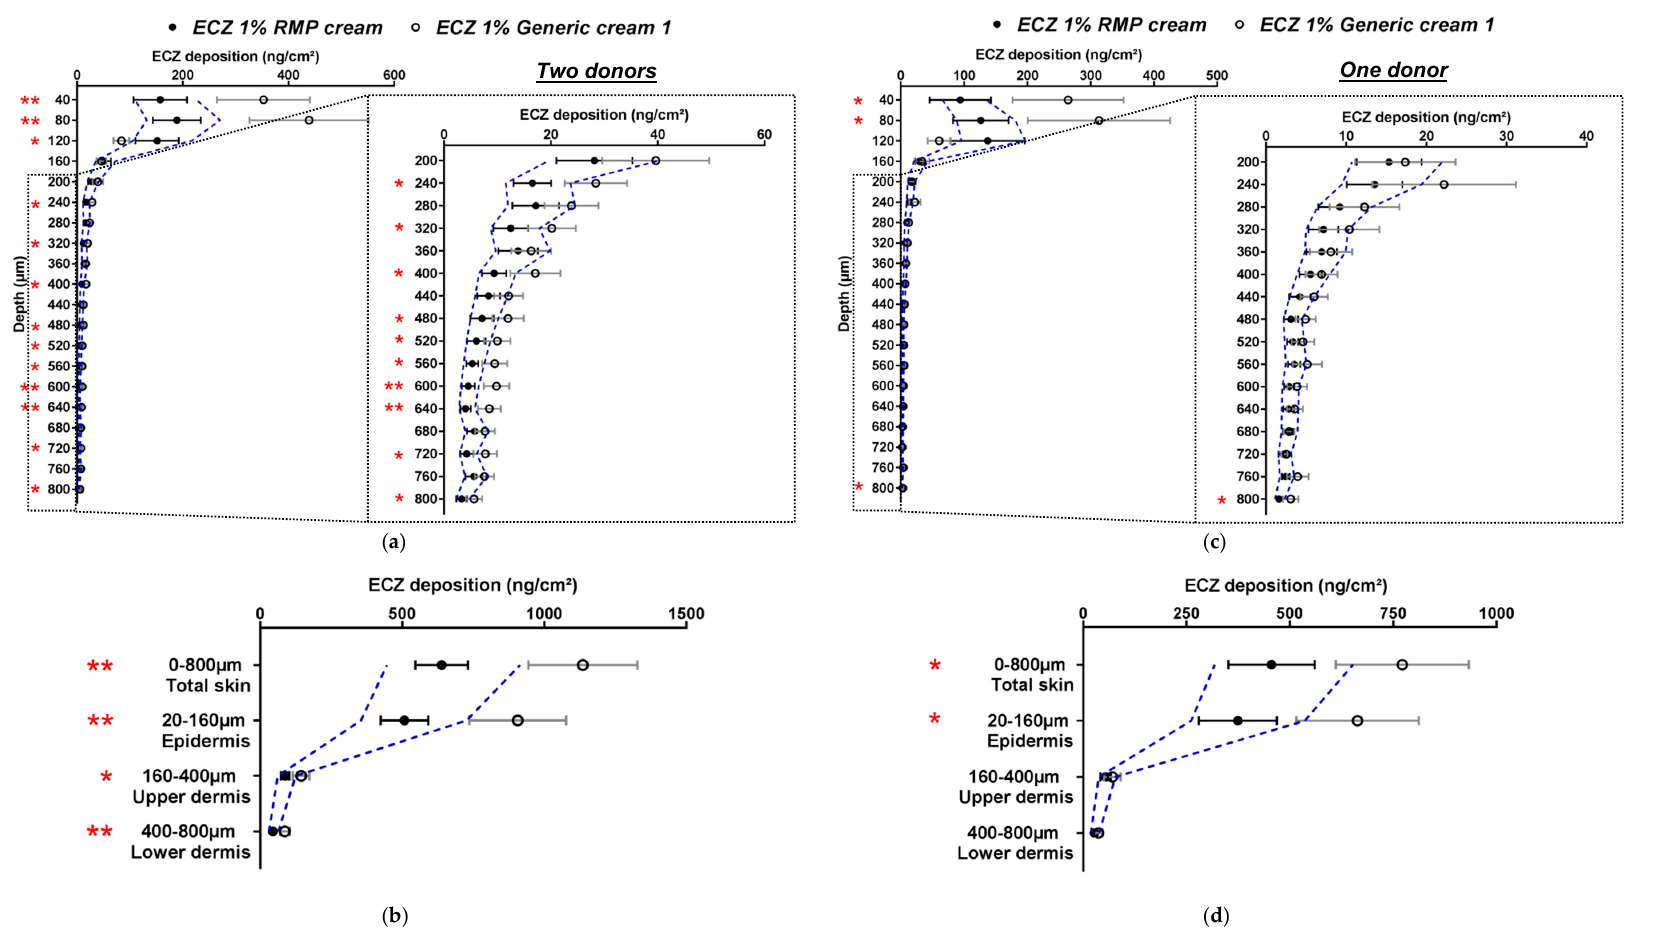
Figure 2. Cutaneous biodistribution profile of ECZ: ( a ) in porcine skin lamellae (2 × 20 µm + 19 × 40 µm) to 800 µm (full depth) and ( b ) as a function of position in the anatomical regions of the skin (epidermis, upper and lower dermis) and in total skin. Tested groups: reference medical product (ECZ 1% RMP cream) ( ) and non-bioequivalent “negative control” (ECZ 1% ethanolic solution) ( ). (Mean ± CI 90% ; n = 12 and n = 6, respectively). Intervals of acceptance criteria were calculated based on the mean ECZ deposition from the RMP; ( ) interval of 80.00–125.00% and ( ) interval of 69.84–143.19%. P -values were calculated using a Student’s t test; statistically significant differences are denoted by asterisks (* p < 0.05; ** p < 0.005; *** p < 0.0005; **** p < 0.00005).